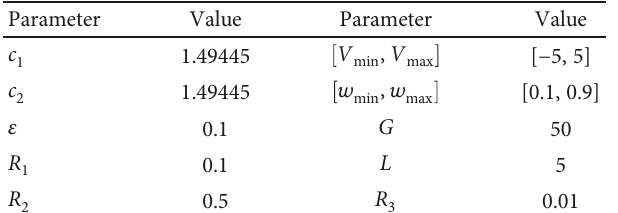
Table 1: Parameters in the simulation.